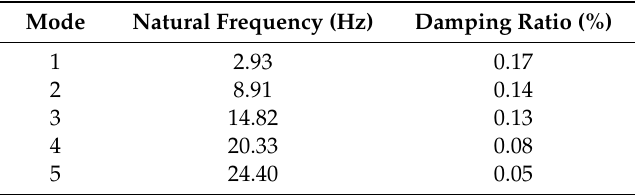
Figure 21. Experimental building model: ( a ) E ‐ W direction; ( b ) N ‐ S direction; ( c ) Simplified shear building model. Table 5. Modal characteristics of the experimental building model.